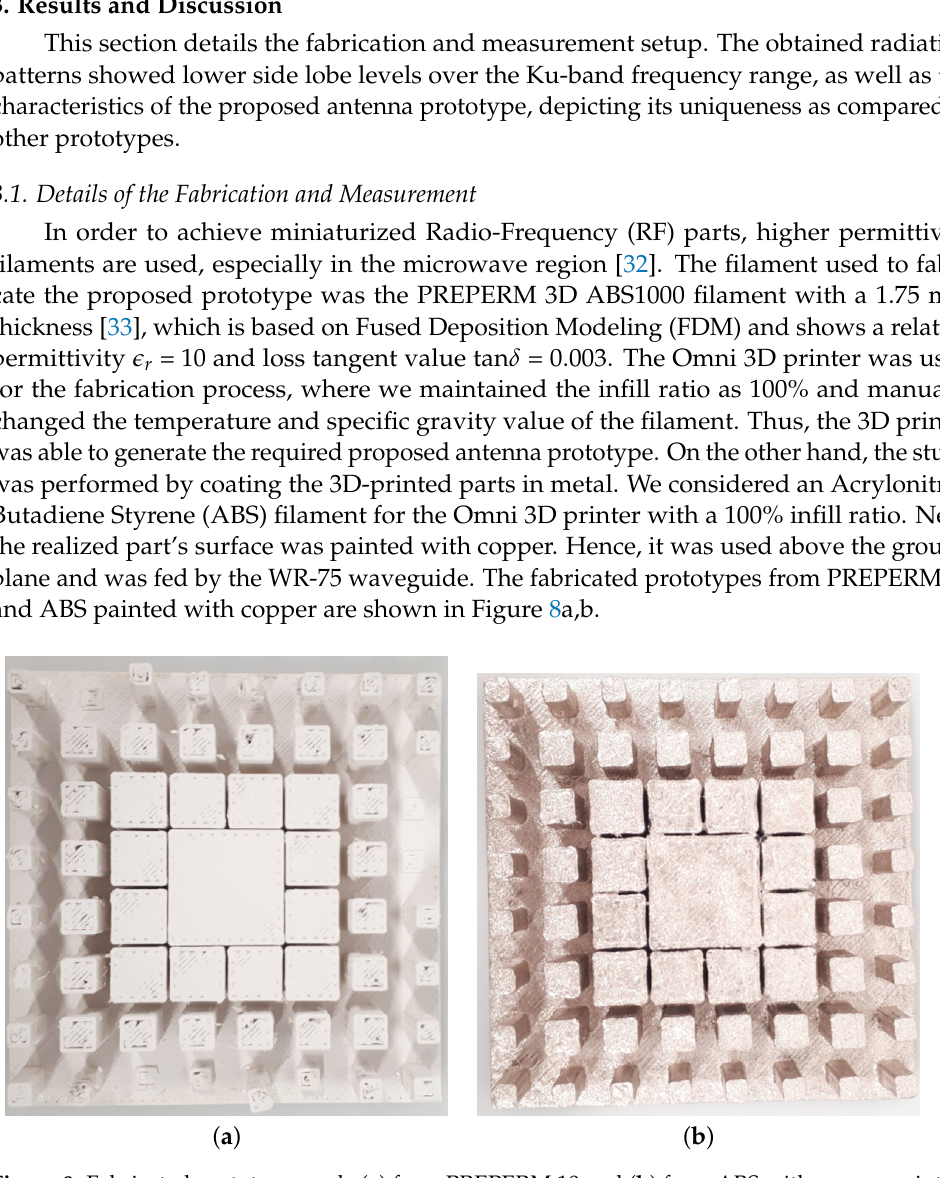
Figure 8. Fabricated prototype made ( a ) from PREPERM 10 and ( b ) from ABS with copper